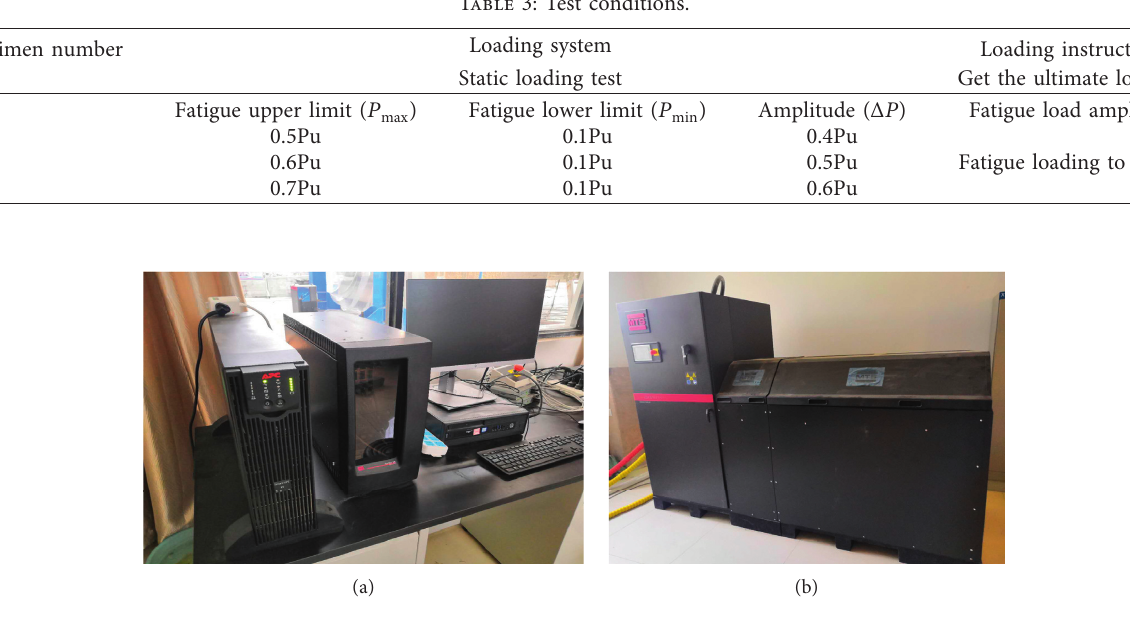
Figure 4: The MTS: (a) control system; (b) hydraulic oil source.